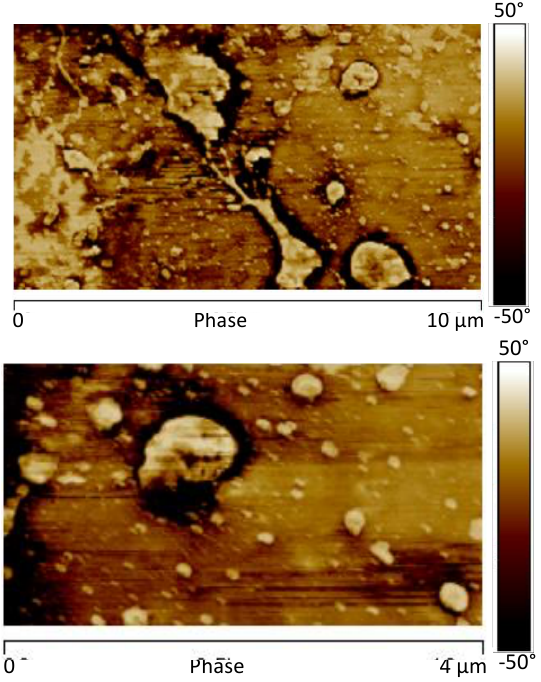
Figure 16. AFM phase map images at two different scan size of the sample 1GNPs.